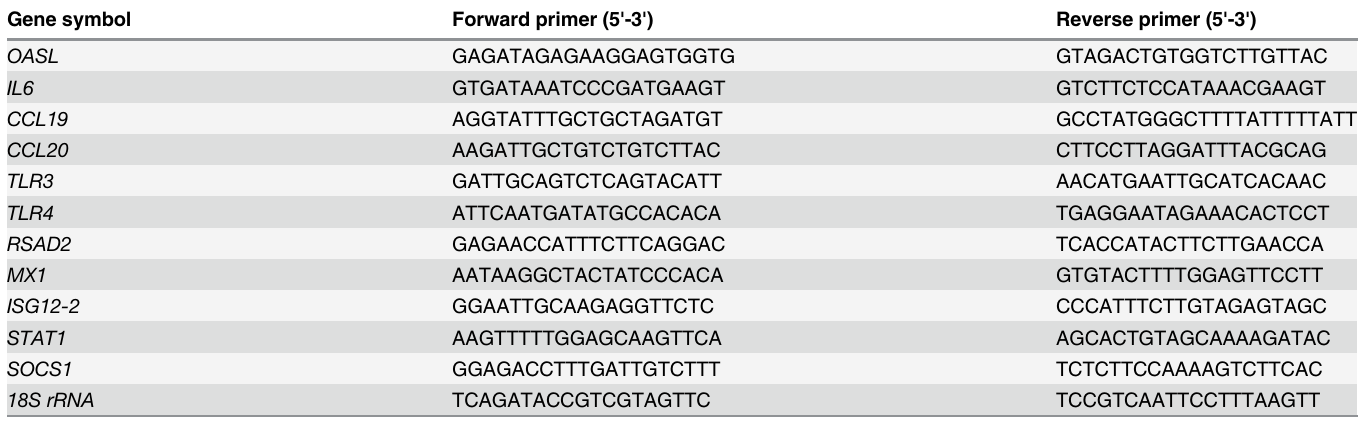
Table 1. Primer sequences for